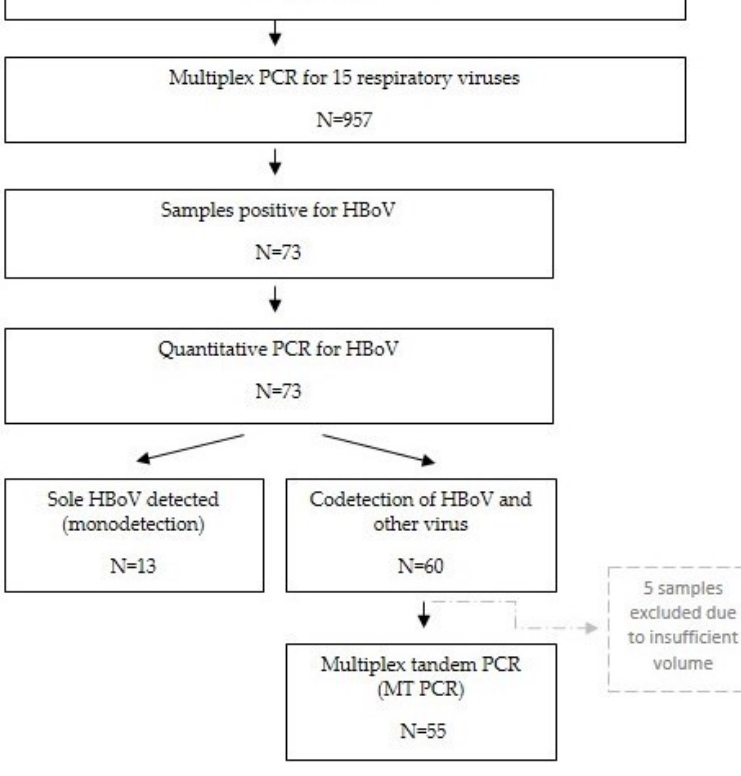
Figure 1. Conceptual framework of the research.